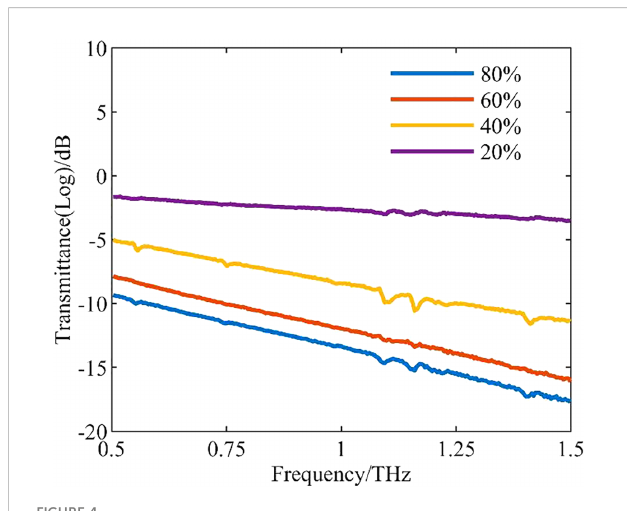
FIGURE 4 Curves of mean transmittance for leaves of different water levels.